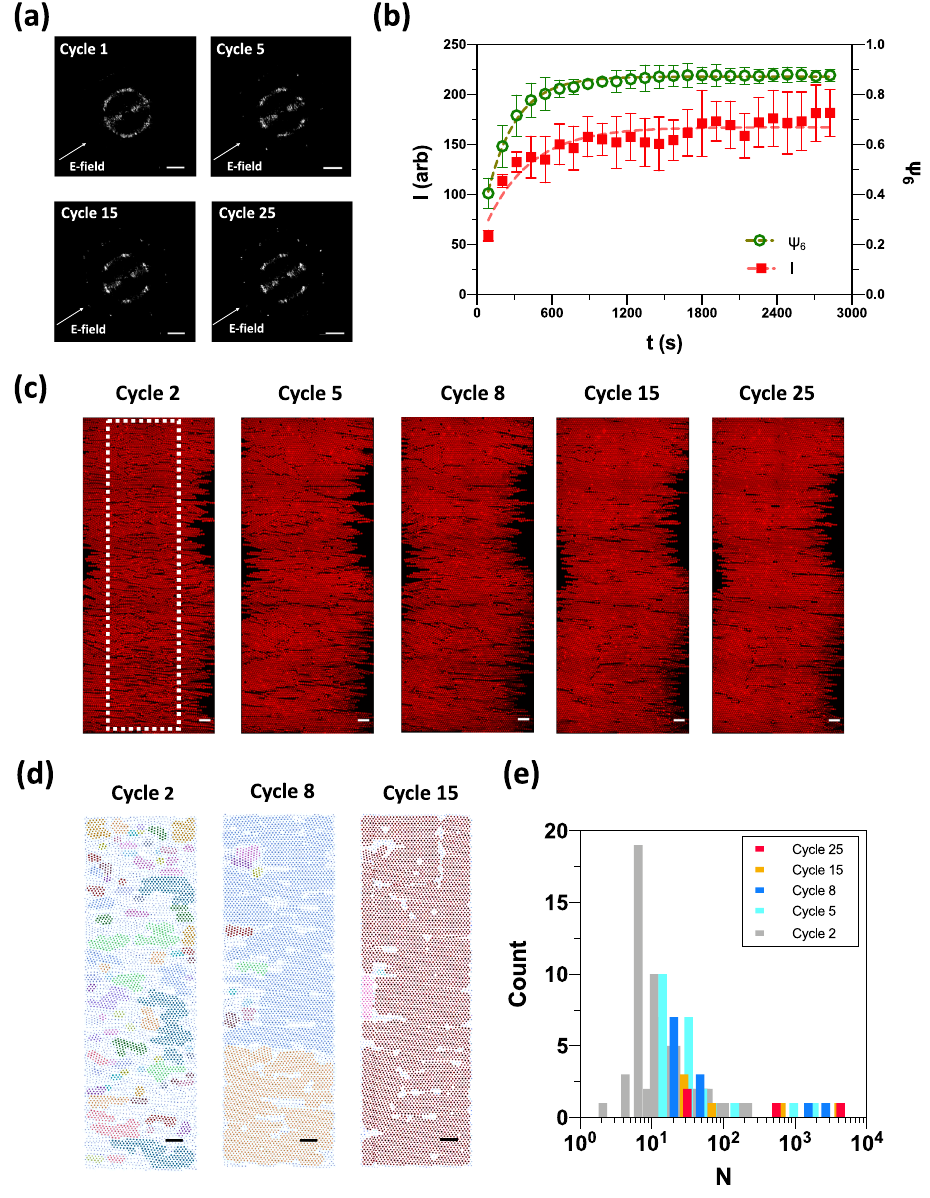
Figure 4. Local and global ordering characteristics of spheres under cyclic electric fields of t off = 0.5 τ 50 . ( a ) SALS images for cycle 1, 5, 15 and 25, respectively. ( b ) The change of peak intensity of light diffraction responses and the change of ψ 6 as a function of time t. The curves plotted are the mean and standard error of the mean for five and three CLSM and SALS experiments, respectively. ( c ) 2D confocal laser scanning micrographs for cycle 2, 5, 8, 15 and 25, respectively. The white dotted line encloses the centerline region for analyzing the distribution of crystalline grains. ( d ) Crystalline grains identified by particle proximity and local ψ 6 phase angle at the device centerline region for cycle 2, 8 and 15, respectively. ( e ) Histogram of the grain size ( N ) characterized for cycle 1 1 µ m 2, 5, 8, 15 and 25, respectively. Scale bars in SALS images are q . Scale bars in ( c ) and ( d ) represent − = 20